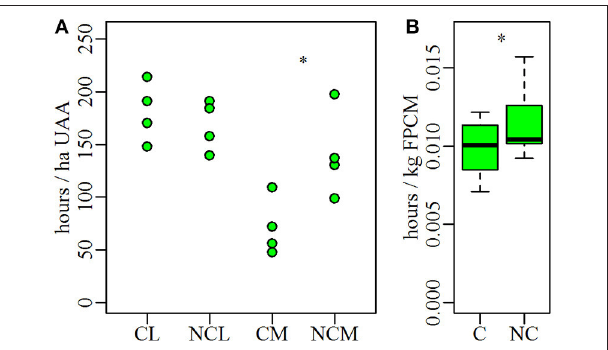
FIGURE 7 | Comparison of workload (A) per hectare usable agricultural area (ha UAA) of the dairy enterprise on collaborating lowland (CL, n = 4), non-collaborating lowland (NCL, n = 4), collaborating mountain (CM, n = 4), and non-collaborating mountain (NCM, n = 4) farms; and (B) per kg fat- and protein-corrected milk (FPCM) in collaborative (C, n = 16) and non-collaborative (NC, n = 16) dairy production systems. Whiskers indicate 1.5 times the standard deviation, and *indicates significant differences between farm groups ( p <